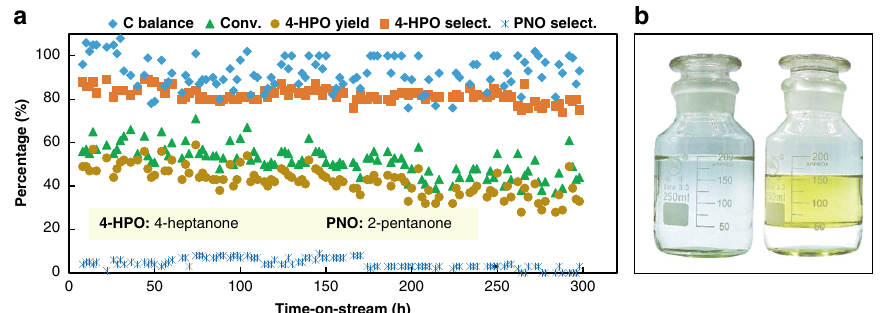
Fig. 3 Stability test of 2 wt% Sn-ceria catalyst in aqueous ABE solution conversion reaction. a Catalytic stability test result. Catalyst (3.2 g, 40 – 60 mesh), N 2 as carrier gas (10 mL min − 1 ), 420 °C, WHSV = 0.5 h − 1 . ABE solution as feedstock with A:B:E:water ratio of 9:51:1:22 (by weight). b Images of ABE feedstock (left) and trapped liquid products